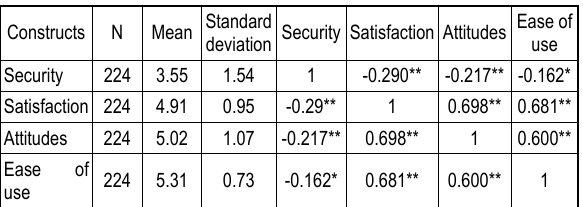
Table 2. Mean, standard deviation and correlation matrix